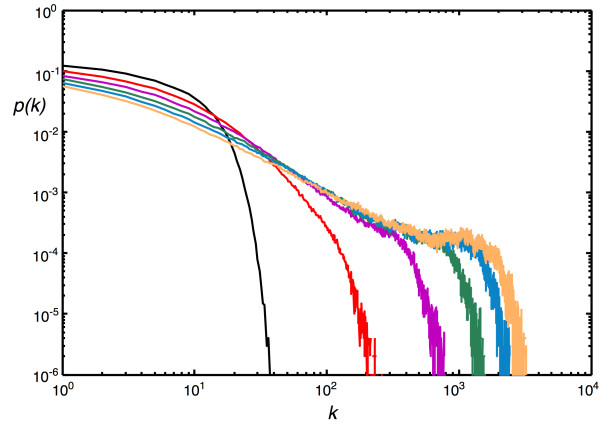
Degree distribution as a function of duplications. The degree distribution of randomly grown networks with different node duplication probabilities PD (r = 1), at fixed PN = 0.2, PE = 0.75 (with p = 1, q = 1). PD = 0 (black), PD = 0.1 (red), PD = 0.2 (magenta), PD = 0.3 (green), PD = 0.4 (blue), and PD = 0.5 (yellow). Average of 100 replicates of networks grown to size n = 1,000.